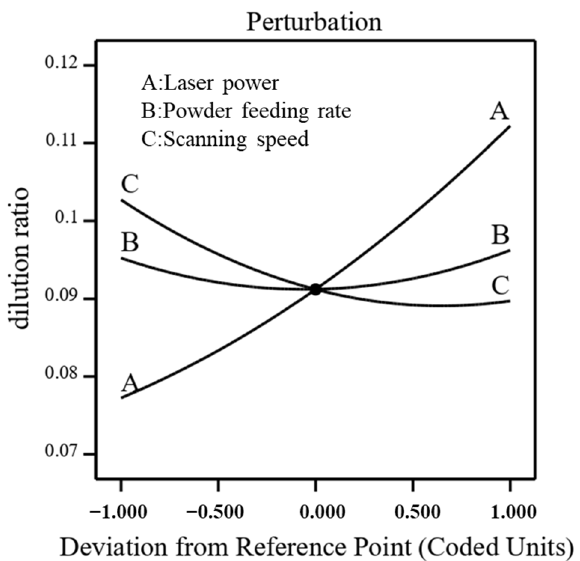
Figure 4. Perturbation of three process parameters to the dilution ratio.